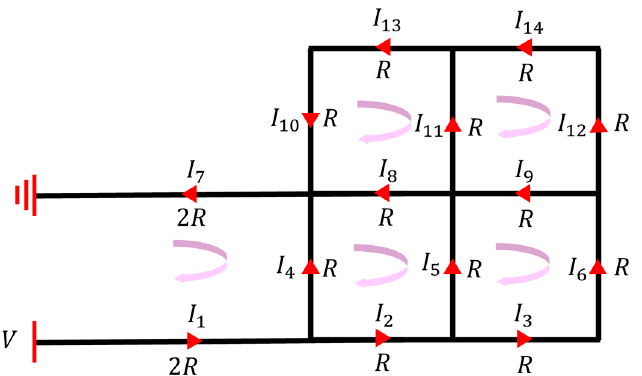
Figure 3. Application of KCL and KVL to the bilayer beam solar sail for current division. The red arrows represent the direction of currents across corresponding beams. The equivalent resistance of each bilayer grid beam was assumed to be 𝑅 , while that of each bilayer supporting beam was 2𝑅 .